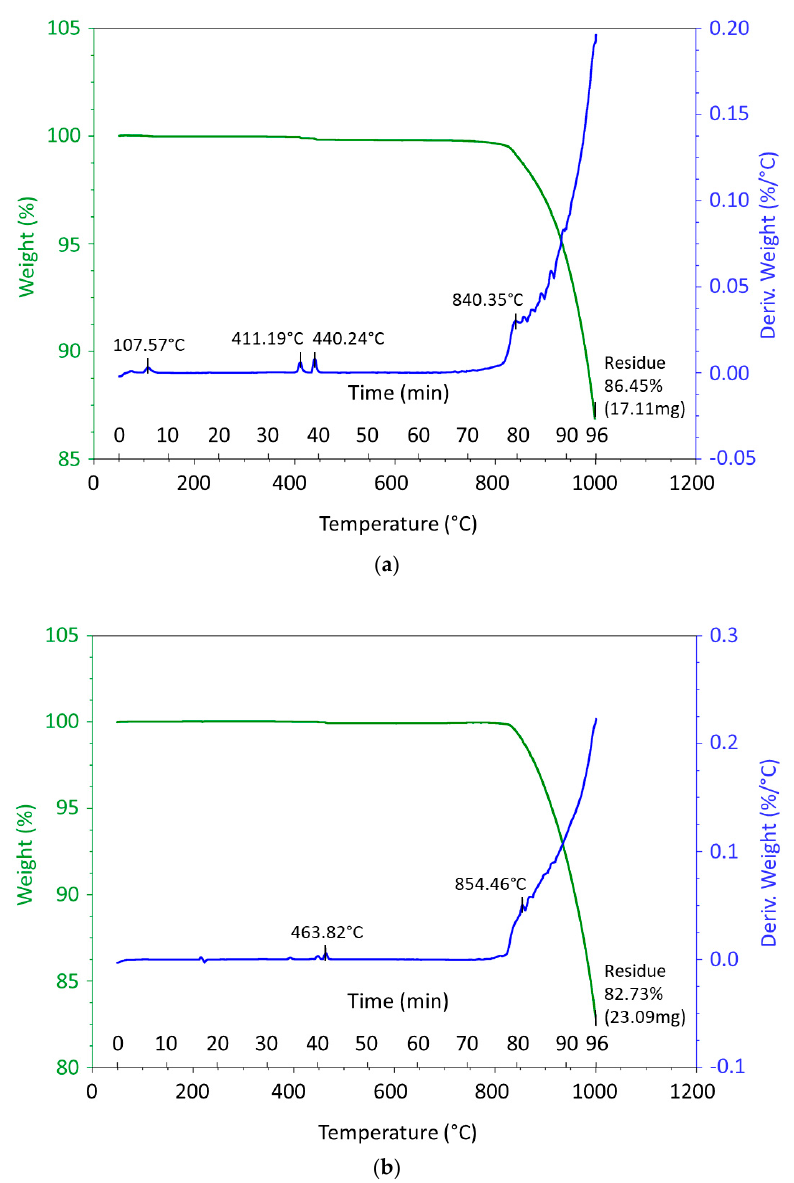
Figure 1. Results of thermal analysis and differential thermal analysis of sample Na Cl I. ( a ) and NaCl II. ( b ).